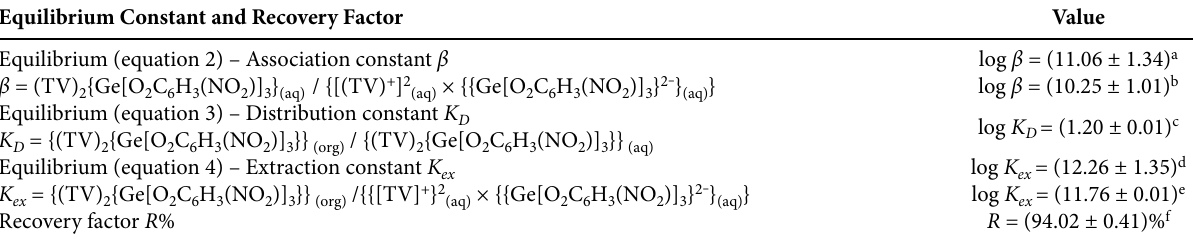
Table 3. Values of the Equilibrium Constants and the Recovery Factor Equilibrium Constant and Recovery Factor